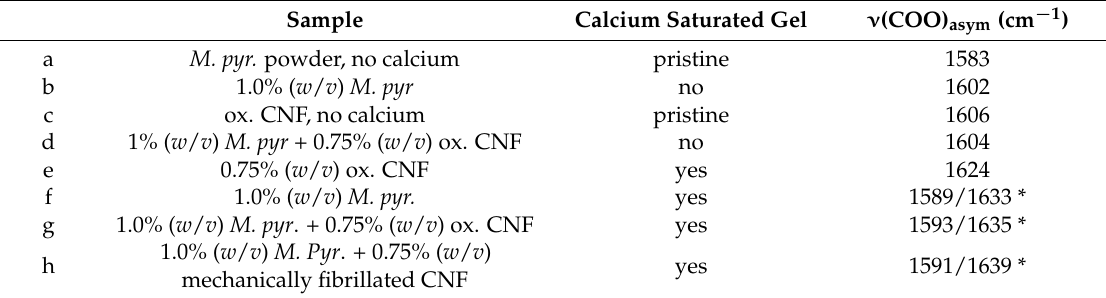
Table D1. FTIR peaks for ν(COO) asym (cm −1 ) for samples shown in Figure 7.